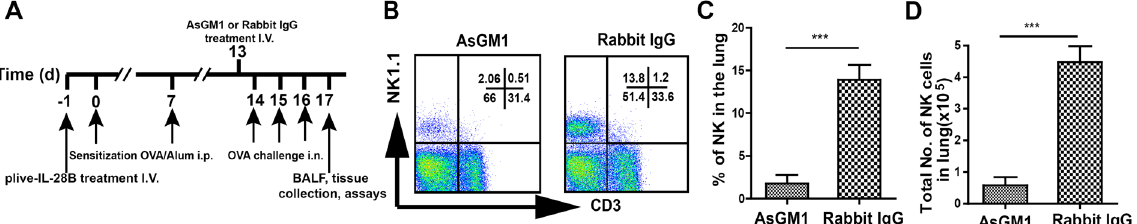
Figure 3. NK cells were depleted in mice by AsGM1. ( A ) Schematic timeline for AsGM1 antibody administration to OVA-sensitized mice and Rabbit IgG was used as control. ( B–D ) Flow cytometry ( B ) and cell counting assays for abundance ( C ) and numbers ( D ) of NK cells in the lung. AsGM1 is anti-asialo ganglioside- monosialic acid. *** p < 0.001 (n = 4 mice per group). Results shown are representative of three independent